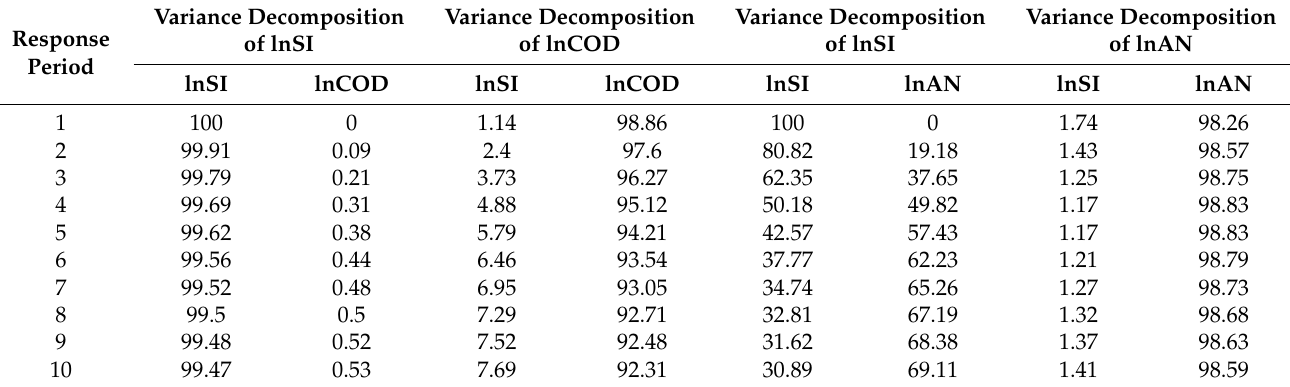
Table 7. Forecast variance decomposition of the discharge of pollutants to the aquatic environment in response to industrial structure adjustment in